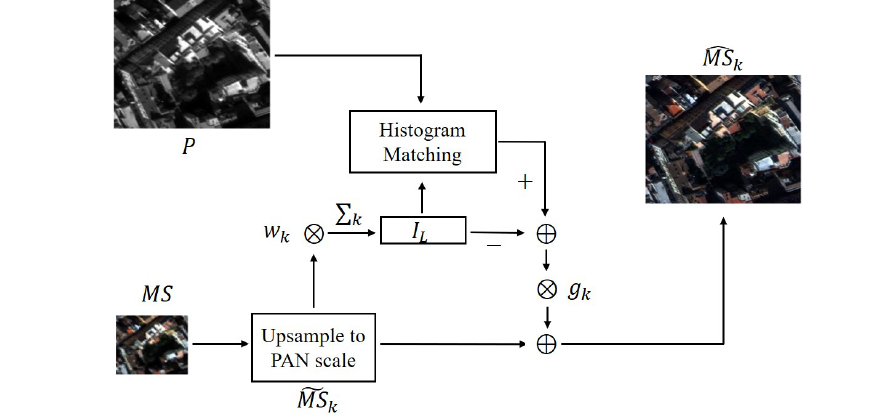
Figure 1. Flowchart of the CS-based methods for